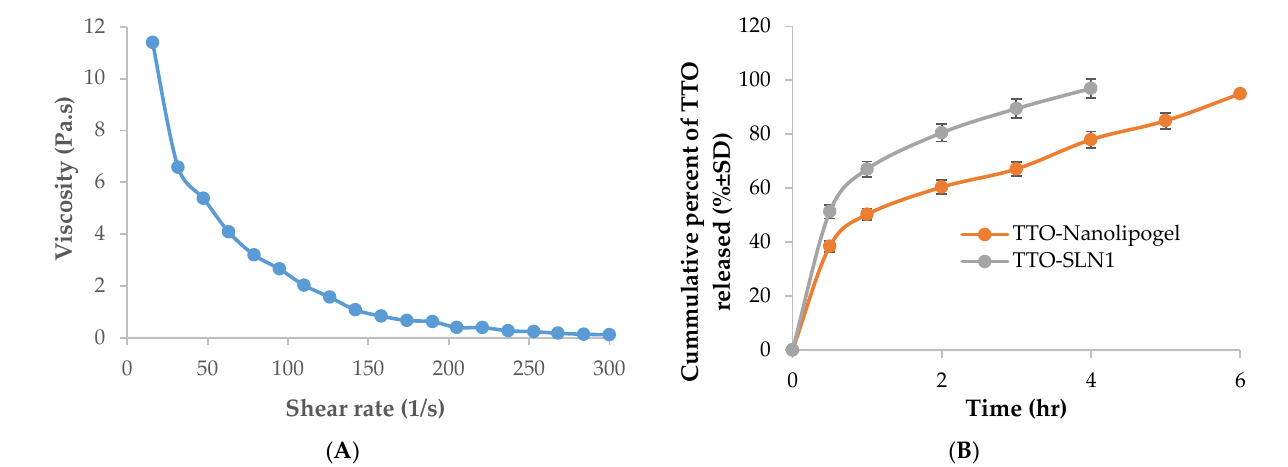
Figure 5. ( A ): Rheogram of TTO-loaded nanolipogel, ( B ): The in vitro release profile from TTO- nanolipogel was compared to that of TTO-SLN1.